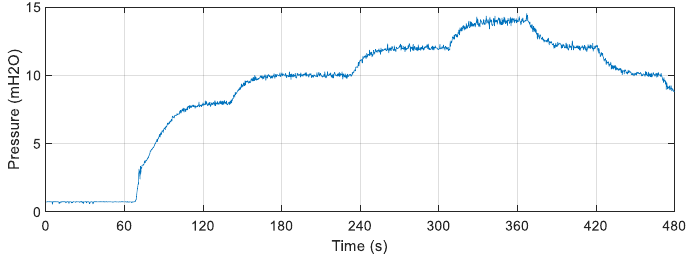
Figure 19. Controlled plant responses with abrupt variations in consumption demand.